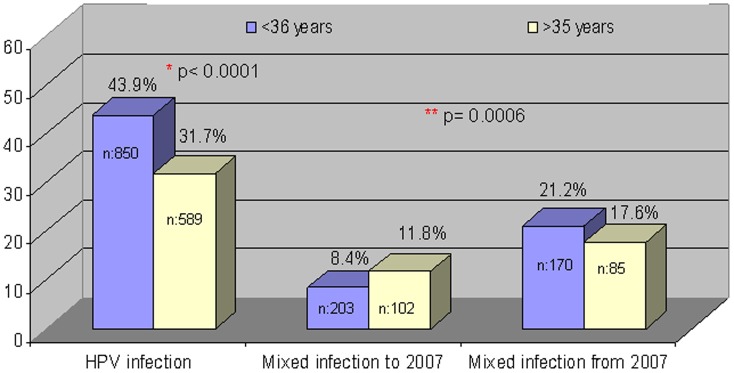
HPV and mixed infection detection rates according to male age groups and period of study.